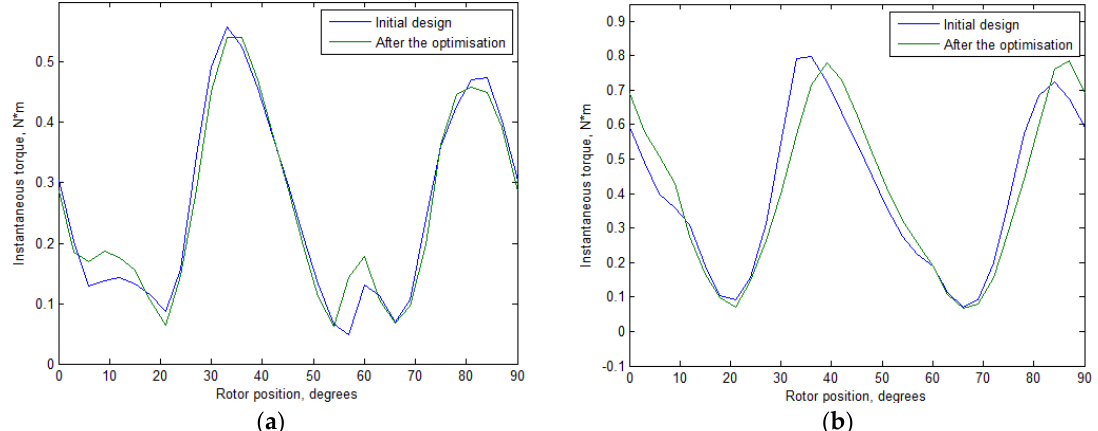
( b ) Figure 2. Calculation area arrangement and flux density magnitude plot (T) in the FRM ( a ) before optimization and ( b ) after. Table 2 shows the variable design parameters of the FRM before and after the opti ‐ mization. Next to the initial value of the variable parameter, its increment at constructing the initial simplex is given. As seen in Table 2 and Figure 2, the maximum flux density decreased as a result of optimization. In addition, the thickness of the yoke, which was underutilized in the initial design, was reduced, which increased the flux density in the yoke. It made it possible to increase the value of R stat , inner . Figure 3 shows the dependence of the torque on the rotor angular position before and after optimization for two loading modes of the FRM with bonded magnets. Figures 4 and 5 demonstrate the waveforms of the current and voltage depending on the rotor angular position before and after optimi ‐ zation for two loading modes of the FRM with bonded magnets. PPTR and AMinTD changed only slightly. This is because the initial design was obtained by scaling the design of the optimized FRM with sintered rare ‐ earth magnets [11]. Figure 5 shows the dependence of the voltage on the rotor position. The voltage waveform is rectangular. The discretization that leads to the non ‐ rectangularity of this voltage waveform on the plots is clearly visible. The motor torque is controlled by adjust ‐ ing the voltage duty cycle. The more torque (mechanical power) that is required, the longer the duty cycle. After optimization, the duty cycle increased in both considered loading modes, taking the optimal values. This is achieved, in particular, by increasing